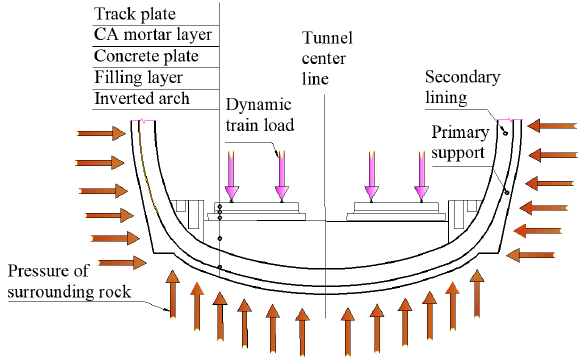
Figure 1. Stress diagram of the tunnel inverted arch.